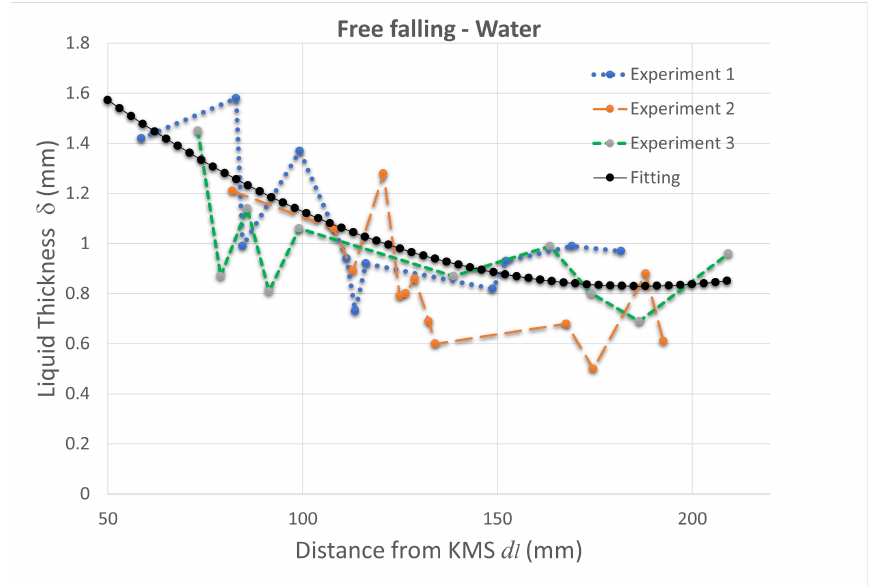
Figure 3. Experimental thickness δ for water. The performance is described from the fitting curve to develop CFD codes along the distance d l where the cyclonic phenomenon